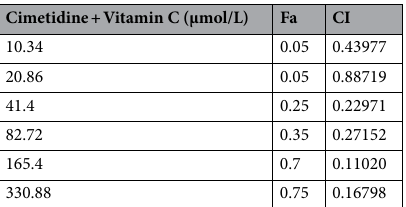
Cimetidine + Vitamin C